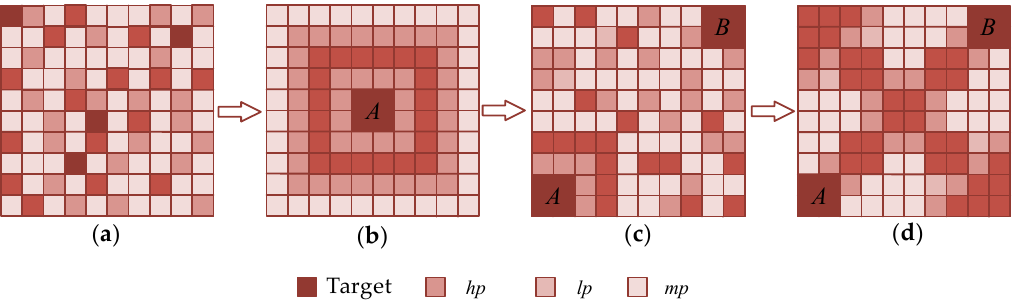
Figure 2. Two kinds of association rule TPM updates. ( a ) initial stage, ( b ) find target A and the TPM is updated according to rule S i , ( c ) find the second target B , ( d ) the TPM is updated according to rule S i + 1 .